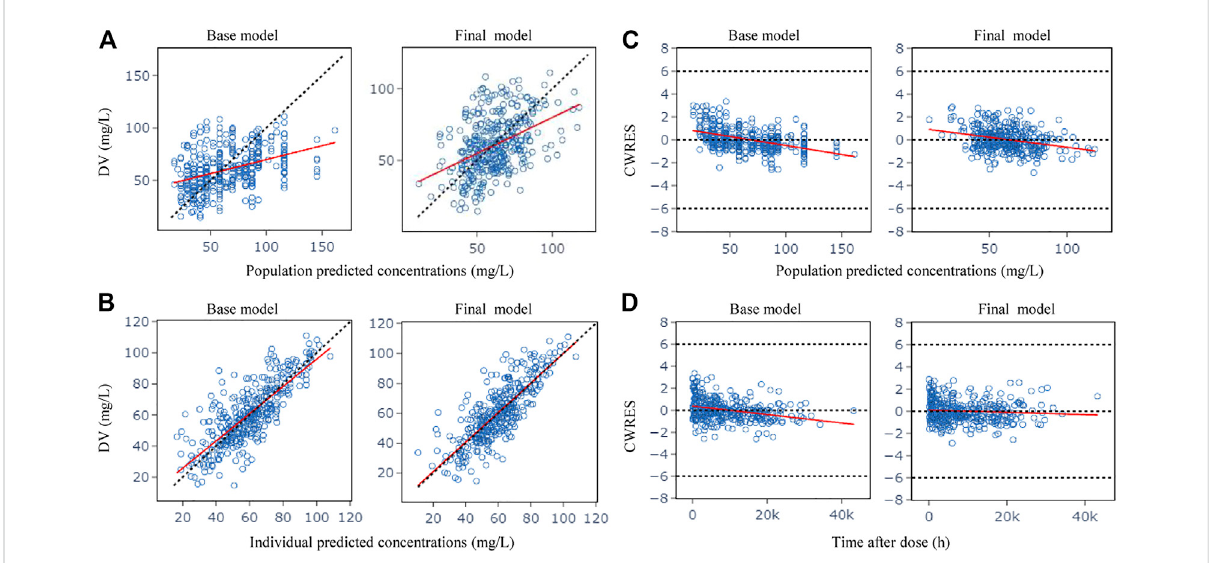
FIGURE 1 Goodness-of- fi t plots for the base model and the fi nal model. (A) Observed (DV) vs. population predicted concentrations (PRED); (B) DV vs. individualpredictedconcentrations(IPRED); (C) Conditionalweightedresiduals(CWRES)vs.PRED; (D) CWRESvs.timeafterdose.Theredlinesinthe panel represent linear fi t